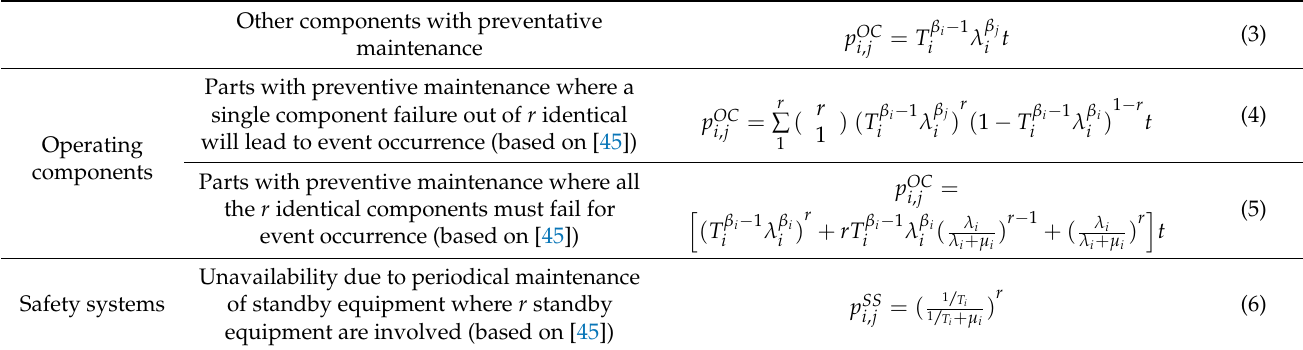
Table 3. Additional